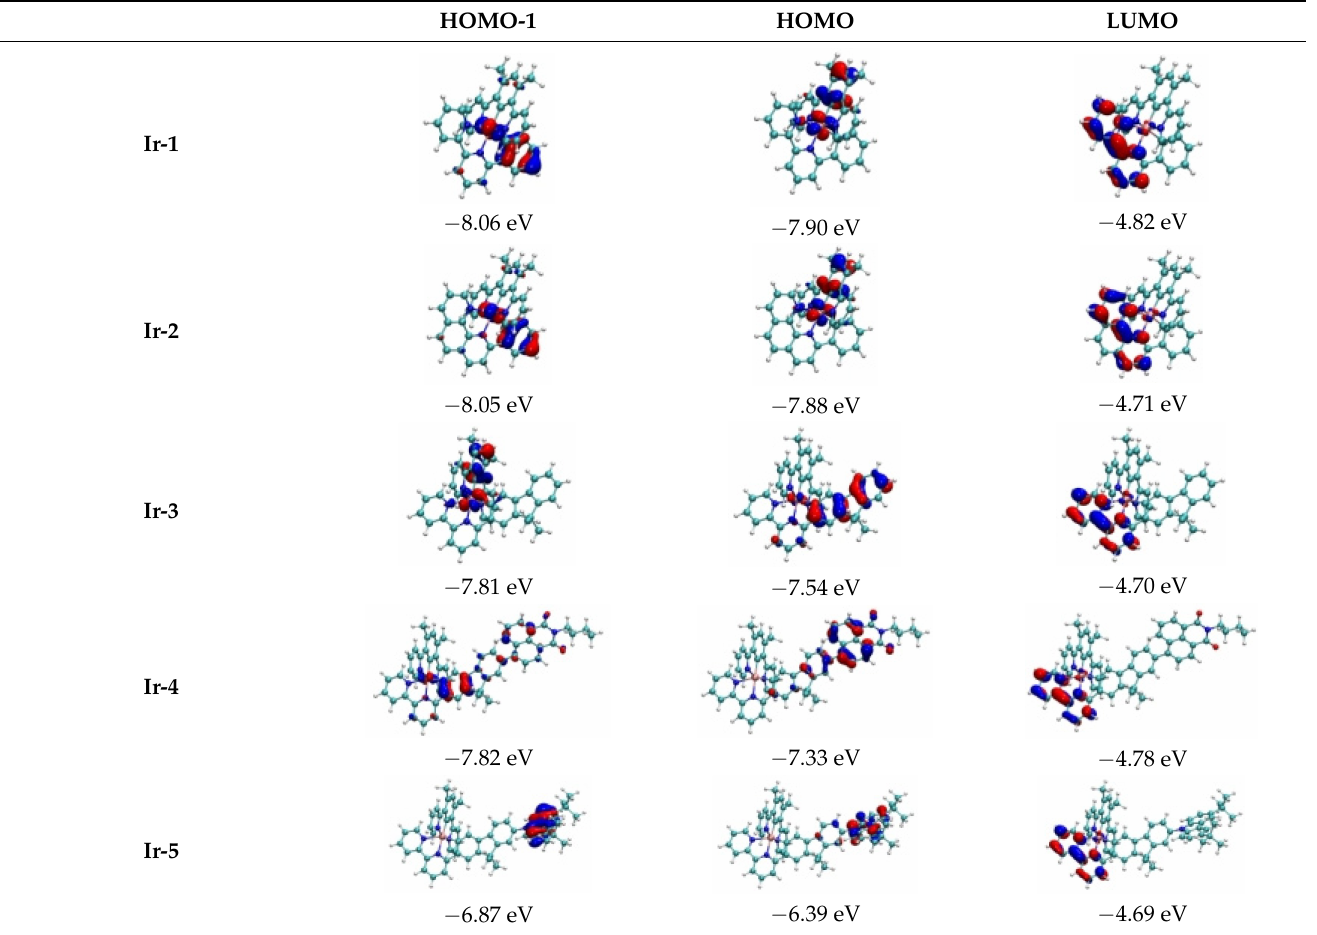
Table 4. Frontier molecular orbitals (HOMO-1, HOMO, and LUMO) in the lowest optical transitions for complexes Ir-1 – Ir-5